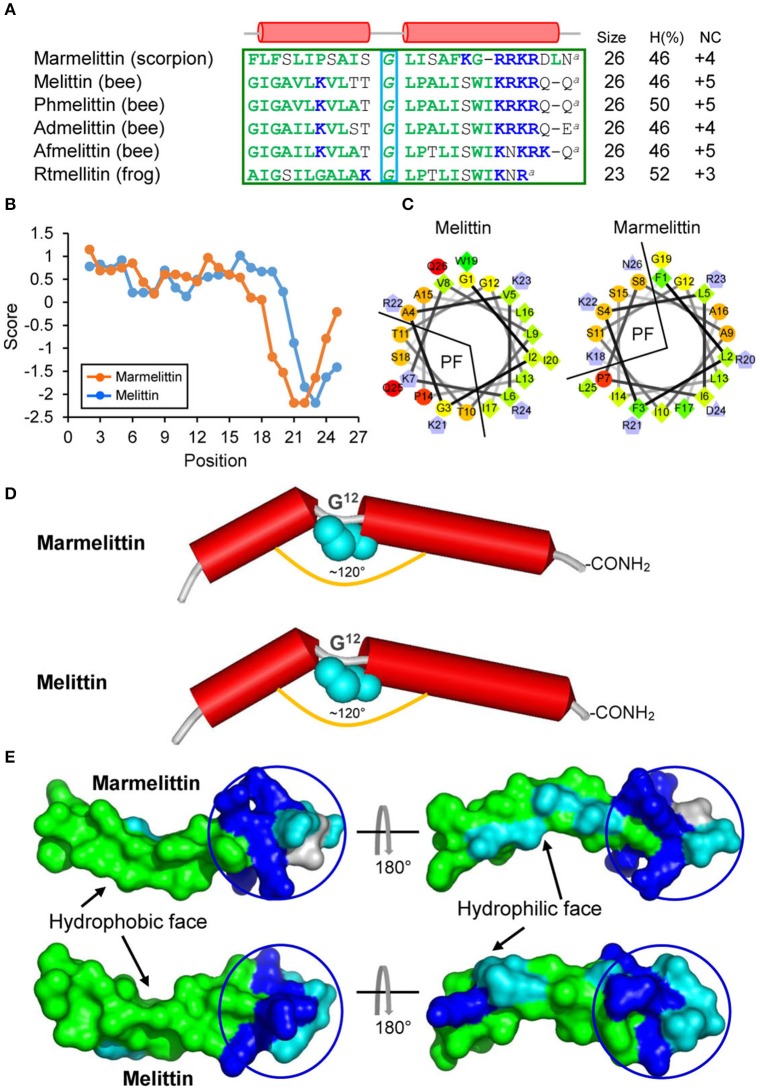
Marmelittin and Melittins. (A) Amino acid sequences. Hydrophobic and cationic residues are shown in green and blue, respectively. “a,” C-terminal amidation; α-helices, indicated by red cylinder, are extracted from the structural coordination of melittin (pdb 2MLT). The structural Gly is boxed in cyan. H (%), the percentage of hydrophobic amino acids. NC, net charge. The source of the sequences used here: Marmelittin from Mesobuthus martensii (AF159979), melittin from Apis mellifera (NP_001011607.1); Phmelittin from Polistes hebraeus (P59261); Admelittin from Apis dorsata (XP_006611828); Afmelittin from Apis florea (P01504); Rtmellitin from the frog Rana tagoi (BAF74741). (B) Hydropathy plots showing hydropathy scores for all the amino acids in the peptides. (C) Helical wheel projections of marmelittin and melittin. Hydrophilic, hydrophobic, negatively charged, and positively charged residues are presented as circles, diamonds, triangles, and pentagons, respectively. The most hydrophobic residue is shown in green, and the amount of green is decreasing proportionally to the hydrophobicity. The most hydrophilic (uncharged) residues are coded red, and the amount of red is decreasing proportionally to the hydrophilicity. Charged residues are shown in light blue. PF, polar face. (D) Structural similarity between marmelittin and melittin. The conserved Gly12 disrupting the helix is shown as cyan spheres. (E) Molecular surfaces of marmelittin and melittin with hydrophobic and hydrophilic regions indicated in green and cyan, respectively. The C-terminal charged/polar region is circled. The experimental structure of melittin (pdb 2MLT) was used as template to generate the structure of marmelittin. The method is detailed in Materials and Methods.